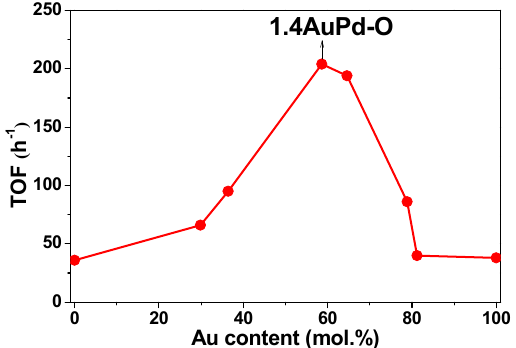
Scheme 1. Reaction pathway of selective oxidation of veratryl alcohol.